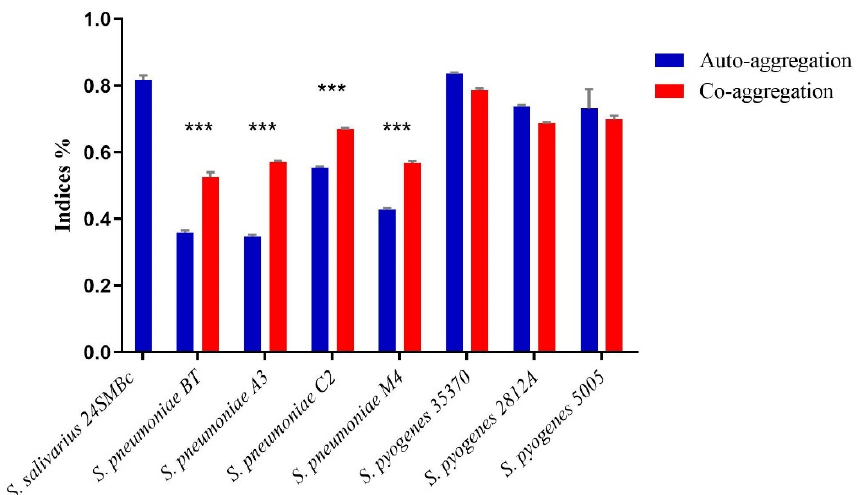
Figure 5. Auto-aggregation and co-aggregation tests. Values of auto-aggregation in blue and co- aggregation in red showed the behavior of each strain when in the presence of S. salivarius 24SMBc. Statistically significant p value: *** p < 0.001